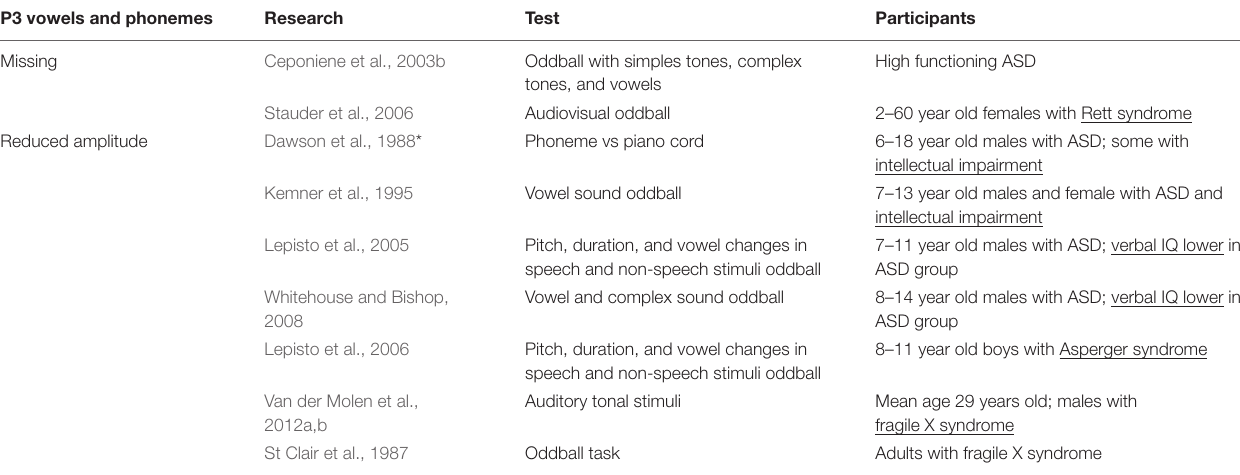
TABLE 5 | P3 latency and amplitude in response to vowel and phoneme stimuli research. P3 vowels and